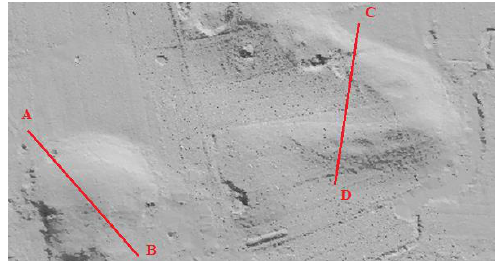
Figure 16. Object 3 - suspected settlement – location of profiles A-B and C-D with shaded DTM